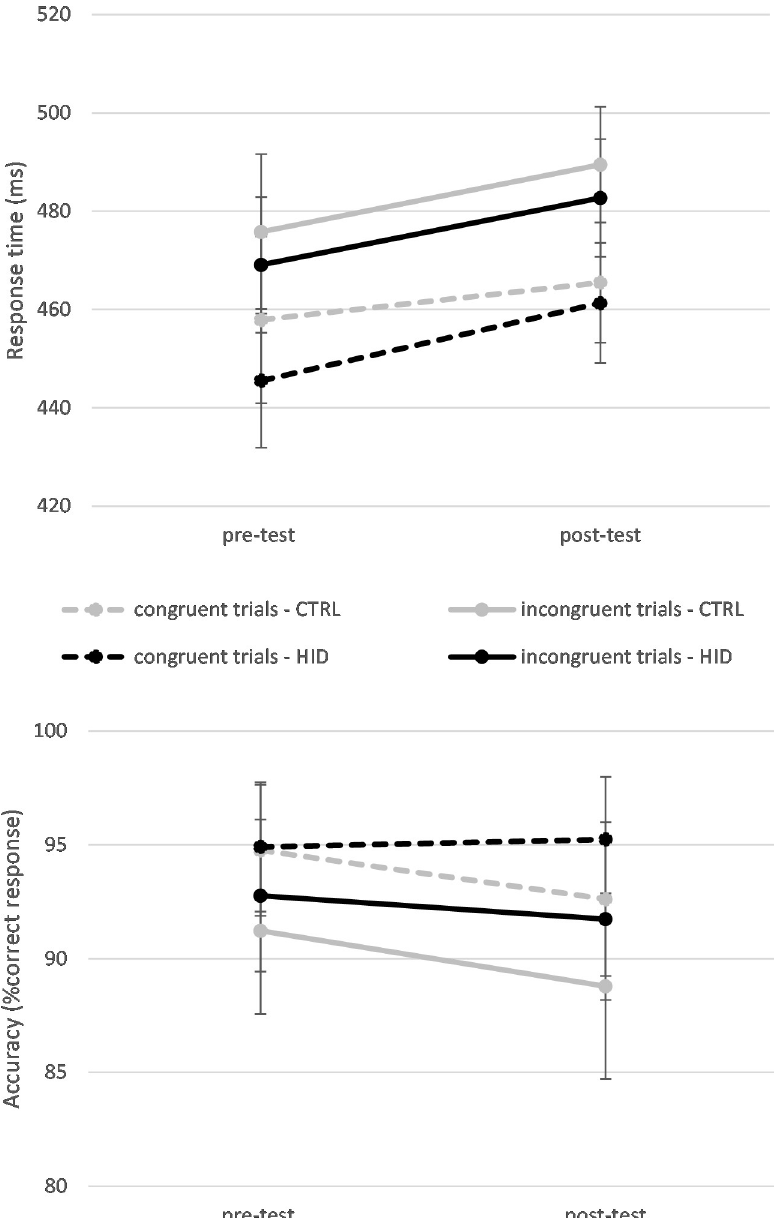
Fig 2. Descriptive statistics (exact means and standard errors of the mean) representing the evolution of response time (upper panel) and accuracy (lower panel) as a function of the time of measurement (pre-test vs . post-test) and as a function of the level of inhibition in the Stroop task (control condition, CTRL vs . high inhibition demands, HID) in Study